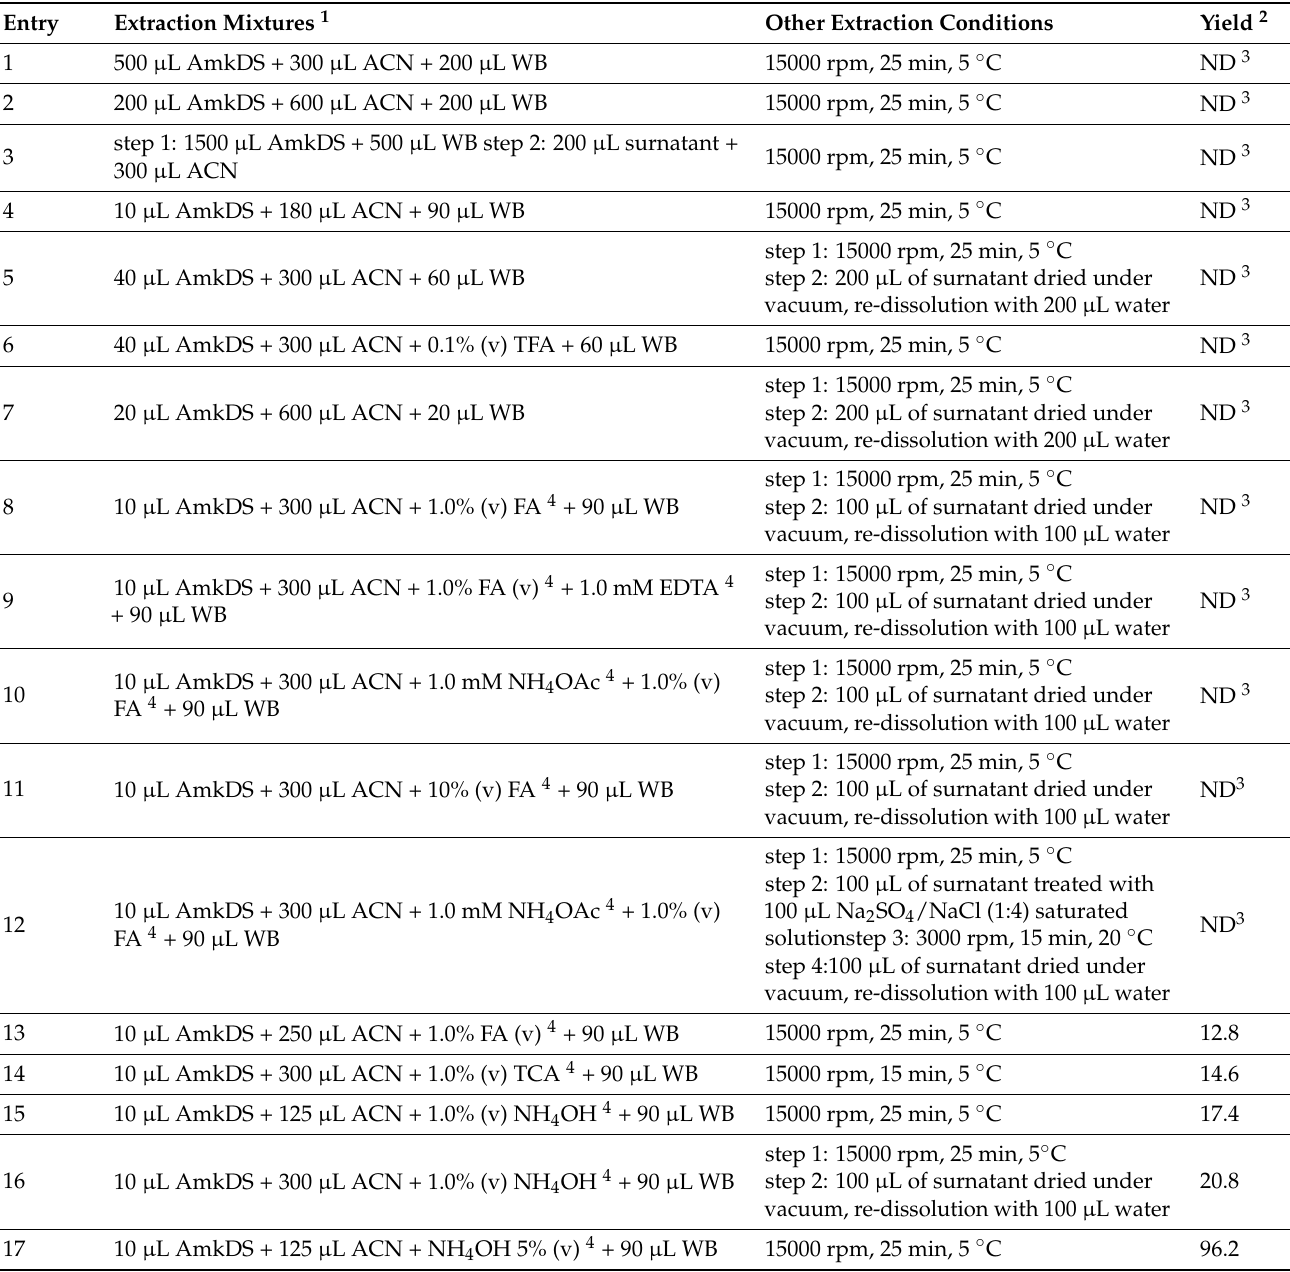
Table 1. Extraction conditions applied in the present study with the corresponding extraction yield. Entry Extraction Mixtures